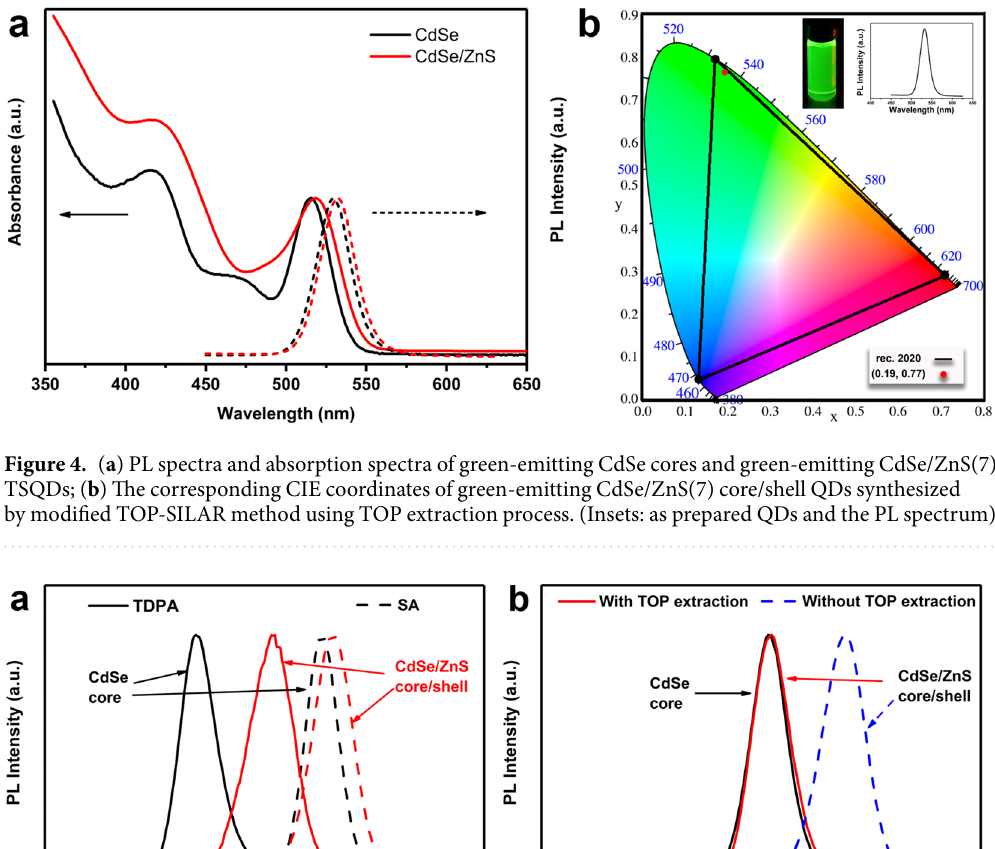
respectively Cd(TDPA) 2 , and Cd(SA) 2 as precursors of the green-emitting QD cores. The later were then used in a typical TOP-SILAR method synthesis of CdSe/ZnS core/shell QDs. When TDPA was used as a ligand to syn- thesize the core without the TOP assisted extraction purification process (Fig. 5(a), solid line), a large amount of metal ion precursors and non-nanocrystalline side products still co-exist in the reaction system due to the low reaction rate 42,43 , resulting in a uncontrollable red-shift of more than 40 nm after the typical TOP-SILAR shell growth process. While in the case of a SA ligand, the fabrication of CdSe core seems to be easier and faster and we assumed that there’s no excess of Cd 2 + remained (Fig. 5(a), dashed line) 44 , showing only a small red-shift of 6 nm after a typical shell growth, however it is still difficult to prepare a fully reacted CdSe QDs with a wavelength less than 550 nm. From now on we worked with Cd(SA) 2 as unique precursor and showed the positive influence of the TOP extraction method as illustrated in Fig. 5(b). In this case, the green-emitting CdSe cores were generated using a cheap reagent (SA) and a rapid cooling process. They were then submitted (red line) or not (dashed blue line) to a TOP-assisted extraction prior to the TOP-SILAR method process. The resulting CdSe/ZnS core/shell exhibits a green emission which successfully overlays that of the core when TOP extraction is used, we assumed that (i) this step is crucial to efficiently remove the excess amount of Cd 2 + ions and non-nanocrystalline side products whether they are on the surface of the CdSe core (as shown in Fig. 1) or in solution, and (ii) the CdSe/ZnS core/ shell QDs can effectively be obtained by this layer-by-layer technique without modification of the emission max- imum 25 . As a comparison (Fig. 5b dashed line and Fig. S3), when no TOP extraction process is applied before the typical TOP-SILAR method, a significant red shift of the emission peak takes place along this process, it is assumed that this is due to the large excess of Cd 2 + and other non-nanocrystalline side products in the medium